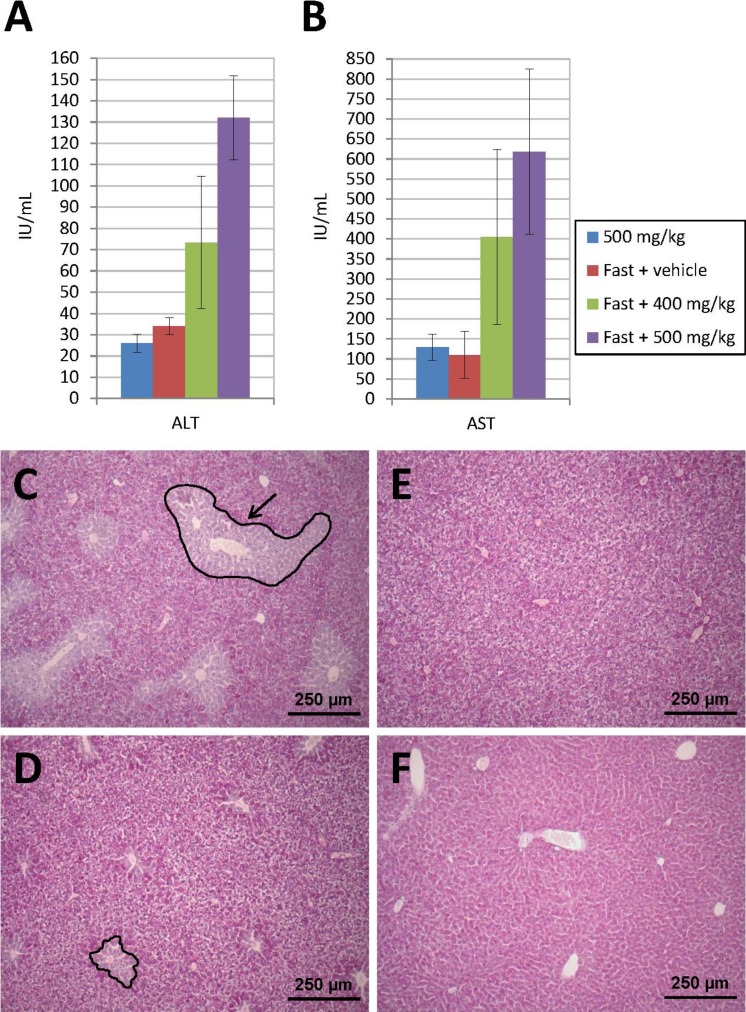
Acute liver injury induced by acetaminophen (APAP) overdose.Serum ALT (A) and AST (B) levels determined 24 h after intraperitoneal injection of APAP. Transaminase elevation is dependent on previous fasting. Animals that enjoyed free access to food did not experience an increase in ALT and AST. Those subjected to an 18-h fasting period showed a dose-dependent transaminase elevation. (C) PAS-stained liver sections show hepatic injury only in animals treated with 500 mg/kg of APAP after a fasting period. A damaged area is indicated by a black line with an arrow. (D) Lesion diameter is much smaller when APAP dose is 400 mg/kg. (E) Control fasted animal only treated with vehicle. (F) Liver section from a fed mouse treated with 500 mg/kg of APAP, where liver injury is not present (original magnification 10×).